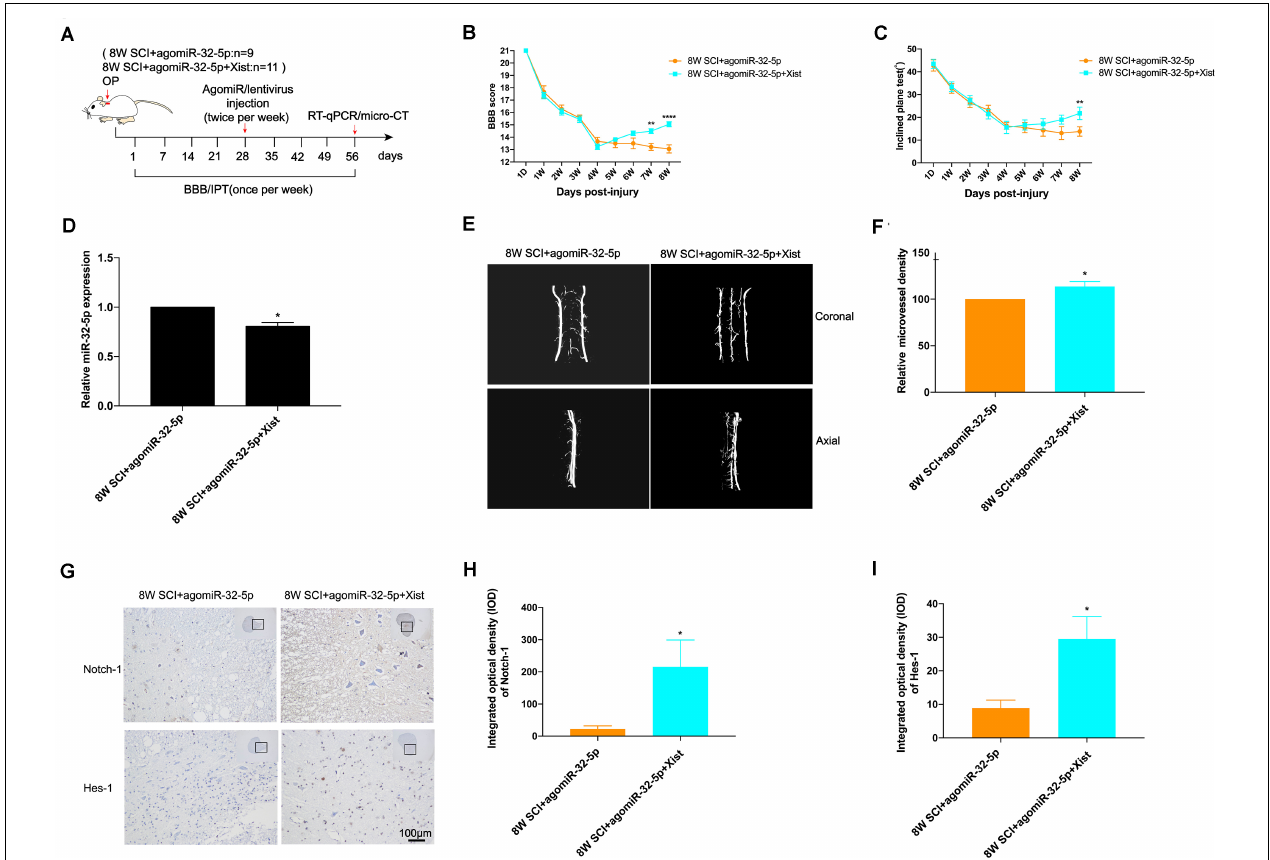
FIGURE 5 | Overexpression of miR-32-5p inhibits endogenous neurological repair and angiogenesis after CCSCI by decreasing Notch-1. (A) Experimental design. (B) Neurological function was evaluated by the BBB score. (C) Neurological function was evaluated by the IPT. (D) Quantitation of the relative miR-32-5p expression. (E) Three-dimensional reconstruction and representative micro-CT images of the microvessels of the cervical spinal cord. (F) Quantitation of the relative microvessel density. (G) Notch-1 and Hes-1 expression was assessed by immunohistochemistry (20 × and 200 × magnification; scale bar, 100 µ m). (H) Notch-1 immunohistochemical staining was quantitated by analyzing the integrated optical density (IOD). (I) Hes-1 immunohistochemical staining was quantitated by analyzing the integrated optical density (IOD). * p < 0.05, ** p < 0.01, **** p < 0.0001. Data are expressed as the mean ±